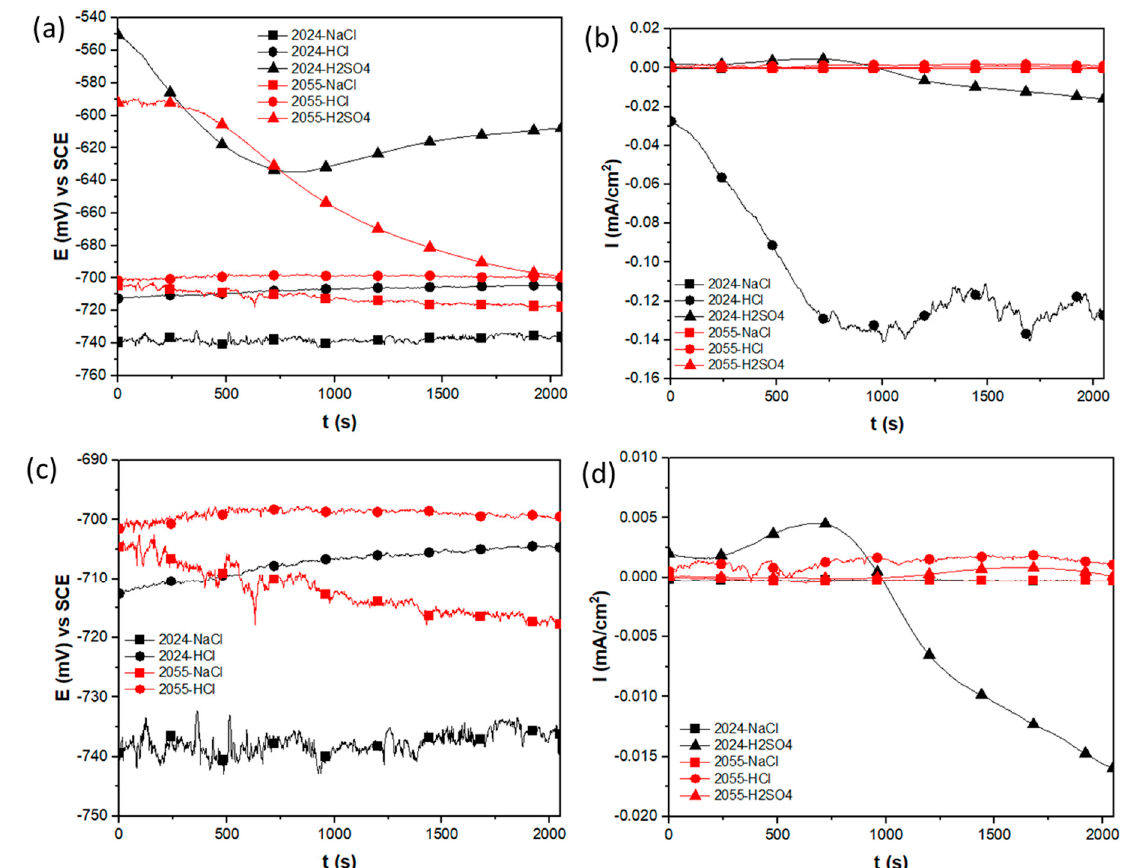
Figure 7. Electrochemical potential noise ( a ) and electrochemical current noise ( b ) noise-time series for AA2024 and 2055 alloys in T6 heat treatment condition, exposed in 3.5 wt. % NaCl, 1 wt. % HCl, and 1 wt. % H 2 SO 4 solutions. ( c ) Windowing of electrochemical potential noise (EPN) from − 690 to − 750 mV ( d ); windowing of electrochemical current noise (ECN) from 0.010 to − 0.020